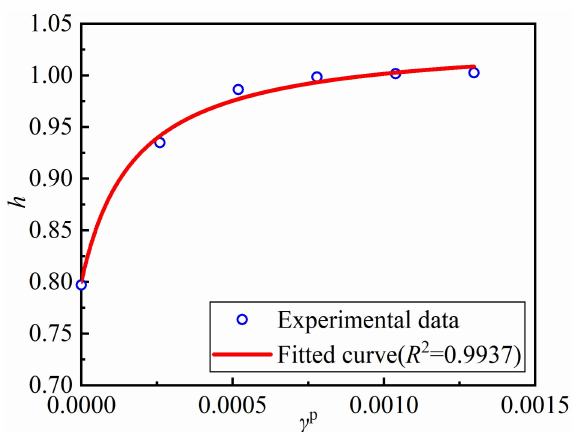
Figure 8. Relationship between h and γ p of Indian